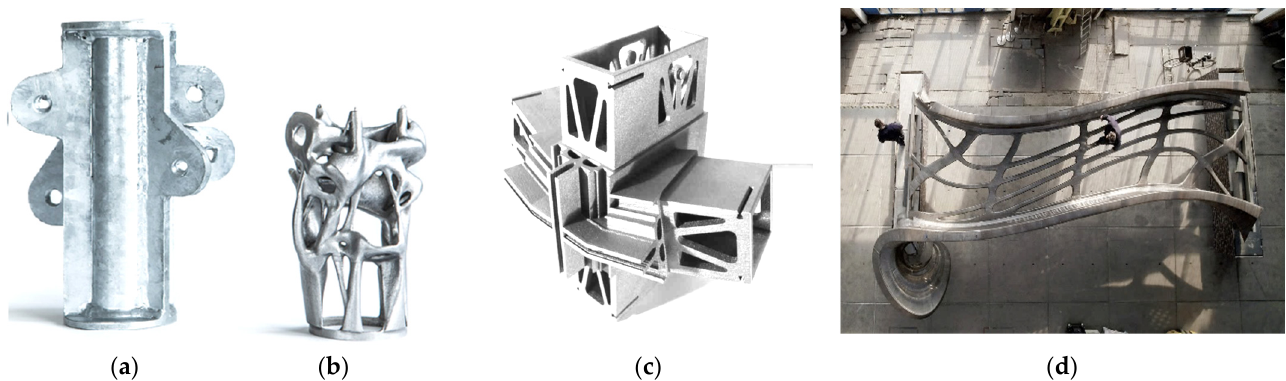
Figure 7. Building components [88]: ( a ) Arup original node, ( b ) Arup topology optimized node, ( c ) Nematox facade node, and ( d ) Max 3D bridge [9].